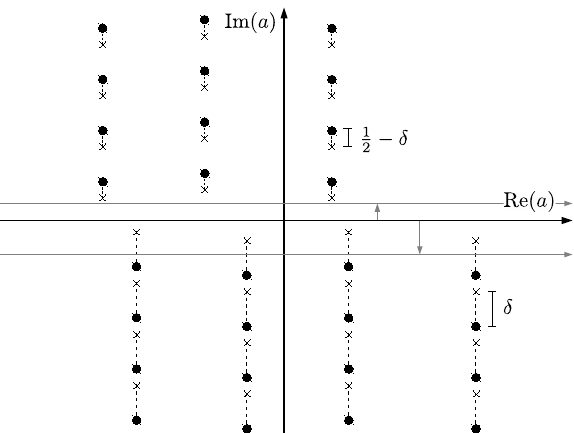
Figure 3 . The insertion of vortex defects moves down the poles in the lower half-plane by (cid:14) = 1 ( d (cid:17) N e (cid:0) (cid:17) N ), and moves up the poles in the upper half-plane by 1 2 contour by i (cid:17) N , the direction depending on the sign of (cid:17) N . 2 downwards by (cid:14) = 1 ( d (cid:17) e (cid:0) (cid:17) ) and those in the upper half-plane upwards by 1 N N 2 shown in (cid:12)gure